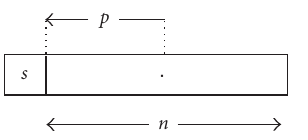
Figure 3: Fixed-point format.